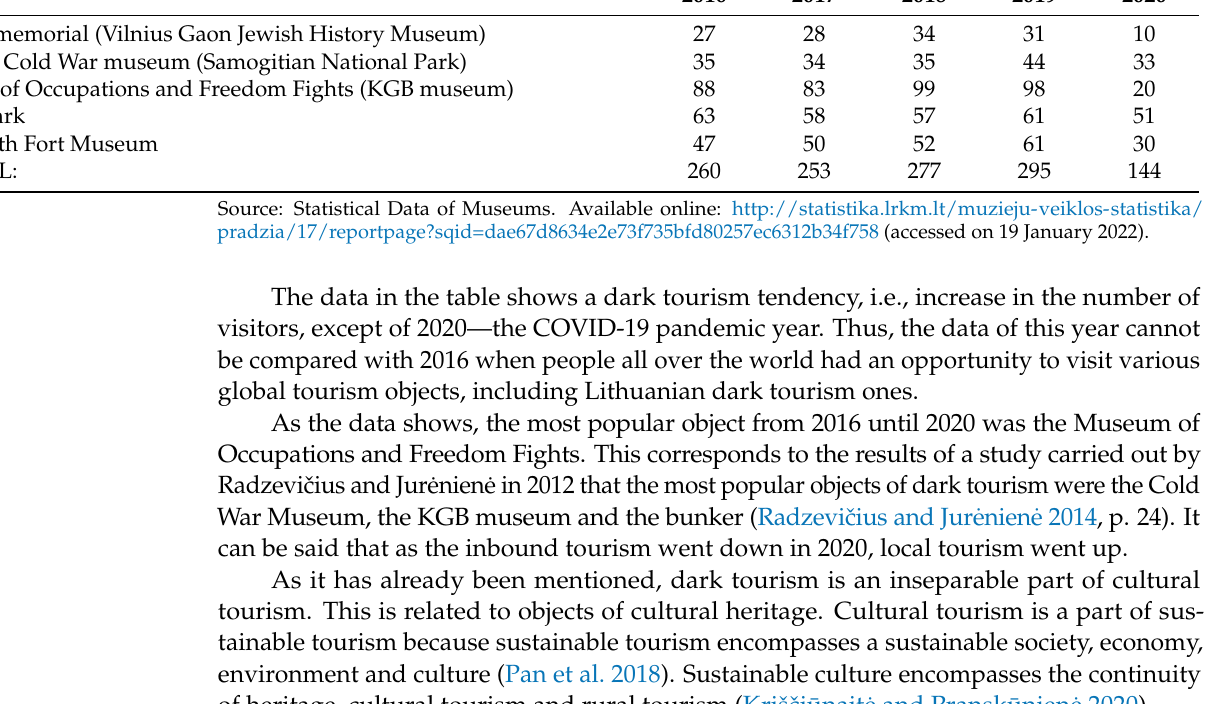
Table 2. Dark tourism objects in Lithuania (2016–2020) 3